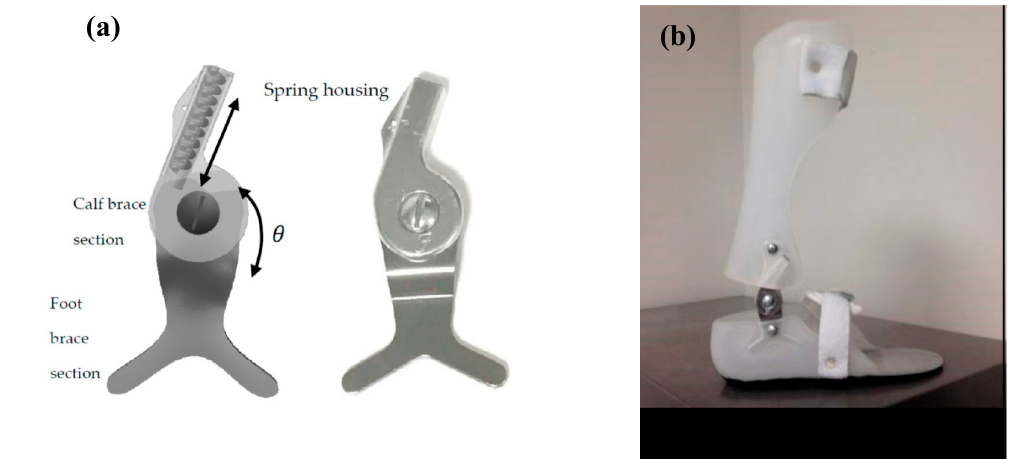
Figure 26. ( a ) Designed superelastic hinge AFO and ( b ) AFO porotype